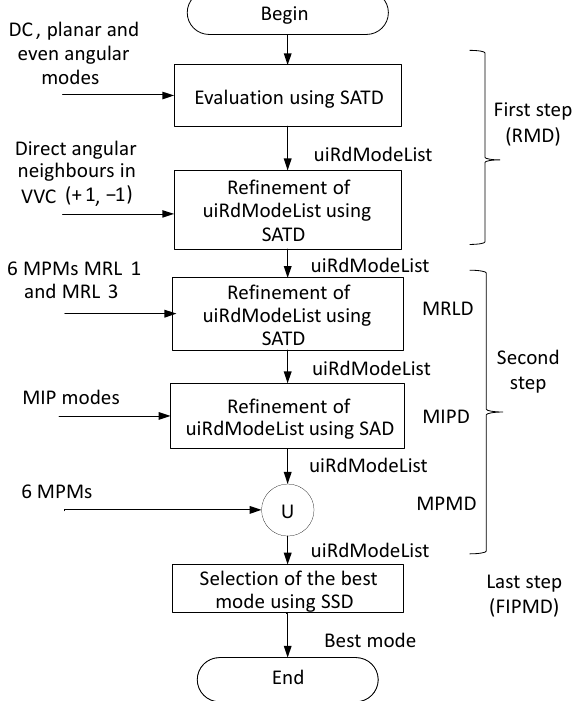
Figure 3. VVC intra-mode decision; uiRdModeList is the list of N candidates; 6 MPMs MRL 1 and 3 are the lists of 6 MPMs of farther reference lines 1 and 3,